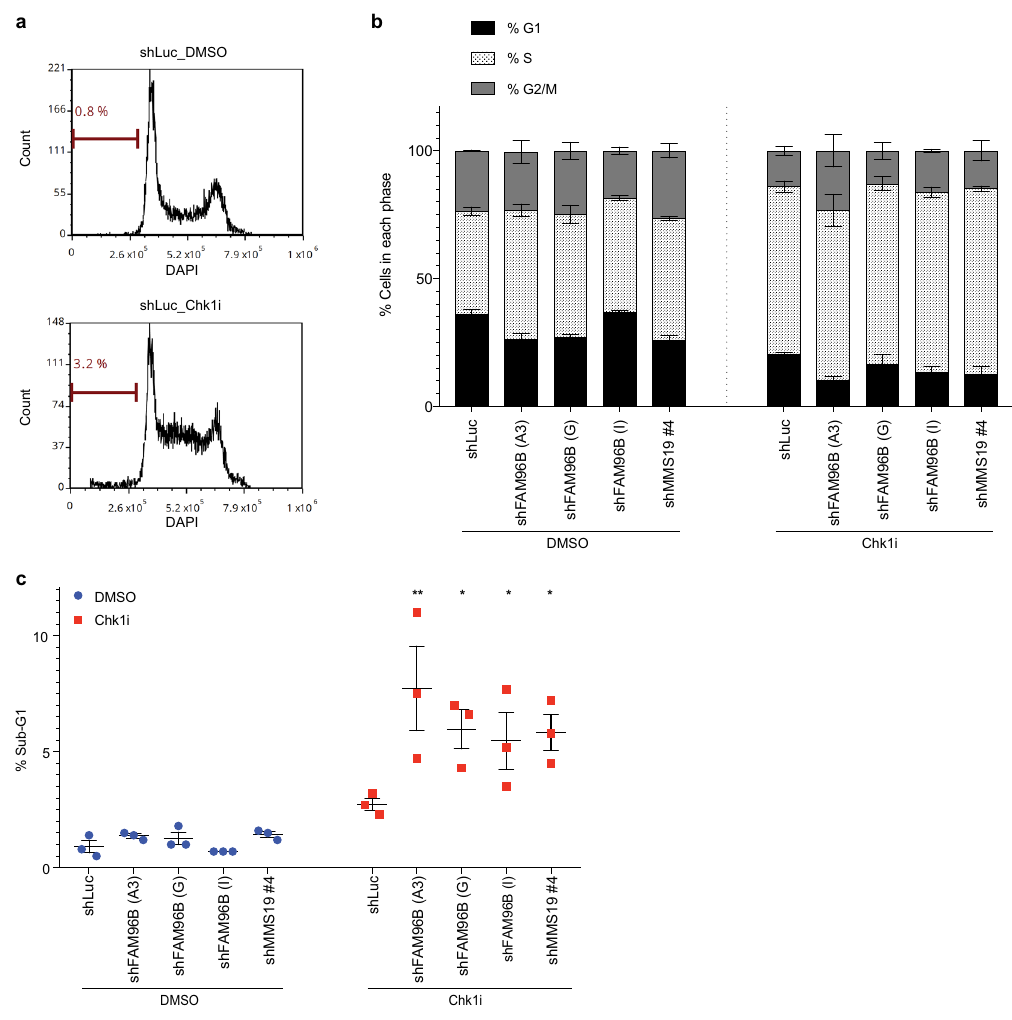
Fig. 5 Chk1i induces expansion of the fraction cells in S-phase in control and MMS19- or CIA2B-FAM96B-depleted cells. shLuc, shMMS19, or shCIA2B-FAM96B cells were treated with 10 nM Chk1i for 24 h prior to being processed by fl ow cytometry. Cells were fi xed with 70% ethanol then DAPI stained to allow for DNA quanti fi cation. a Representative histograms of shLuc cells demonstrates increased S-phase fraction along with modest increase in sub-G1 apoptotic fraction in Chk1i vs. DMSO-treated cells. DNA content analyses were performed using the ModFit module in fcsExpress software. b The fraction of cells in G1, S, and G2/M was quantitated using FCS Express. Datapoint — mean; error bars — SEM of three independent experiments. c Quanti fi cation of the fraction of sub-G1 cells for each sample reveals statistically signi fi cant higher levels in sub-G1 population in Chk1i-treated shCIA2B-FAM96B- and shMMS19-depleted cells compared to shLuc cells. Datapoint — mean; error bars — SEM of three independent experiments. * p < 0.05, ** p < 0.005 (two-way ANOVA, Dunnett ’ s multiple comparisons